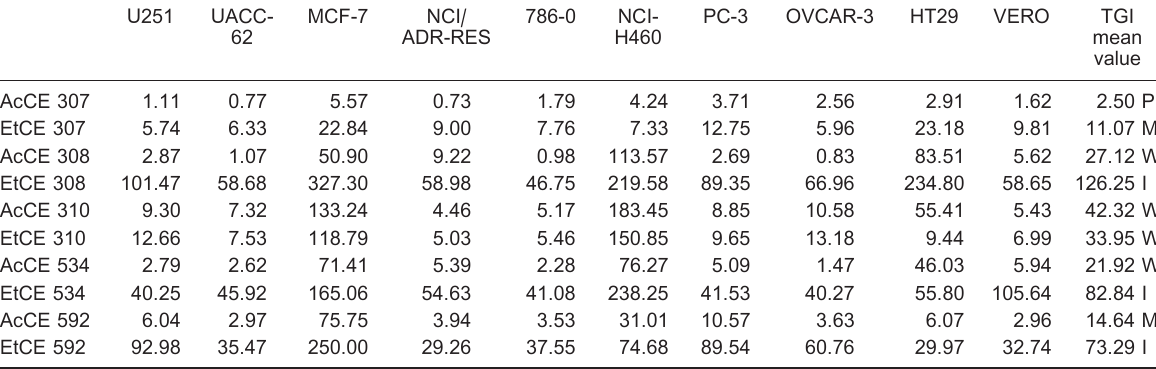
Table 1. Cytotoxic activity, reported as TGI values, of crude extracts of Chromobacterium sp isolates tested against human tumor cell